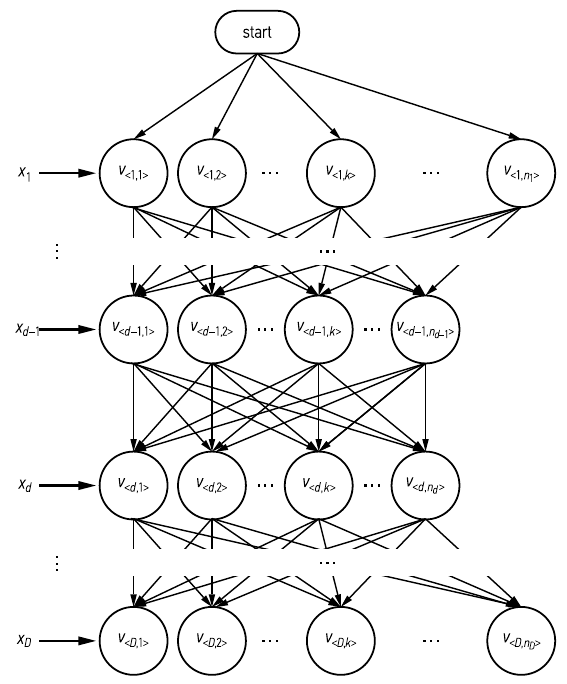
Fig. 2. Search graph